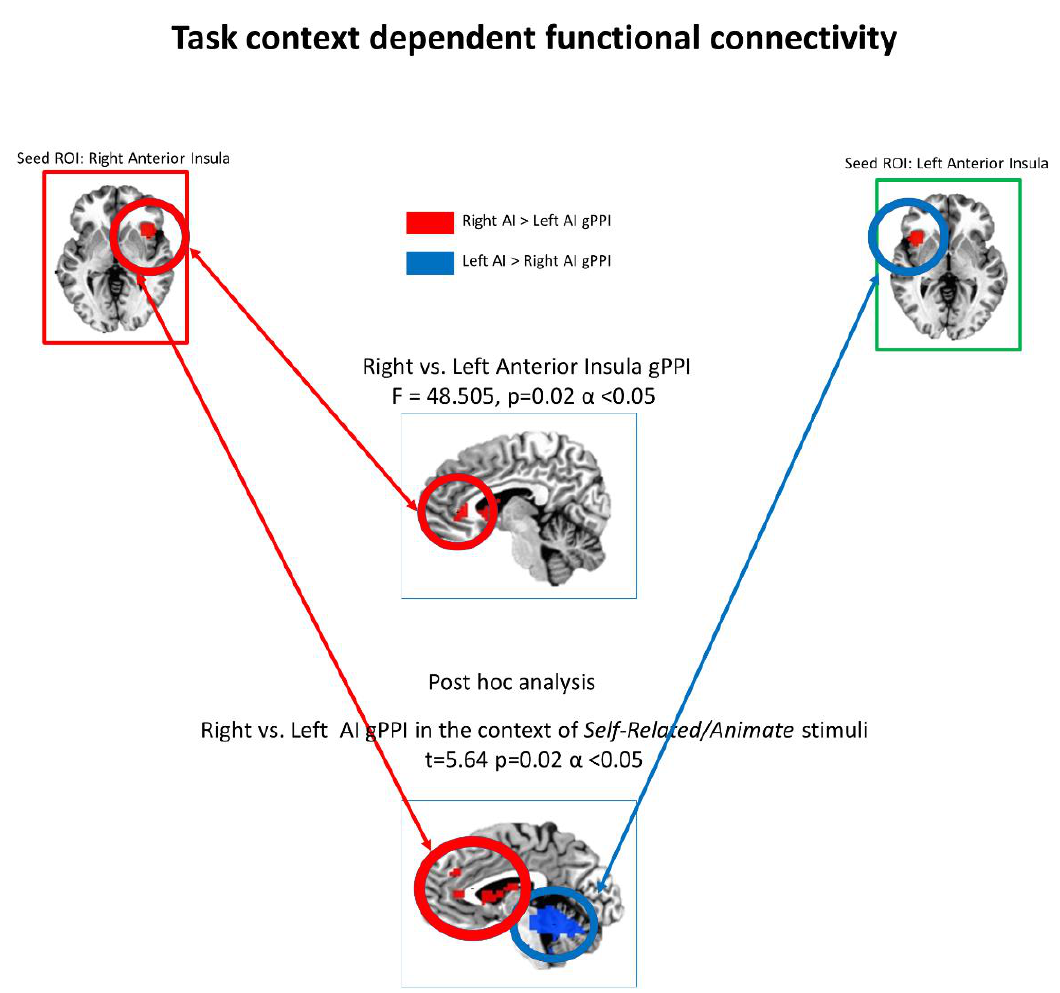
Figure 2. Task context-dependent functional connectivity—Generalized Psychophysiological